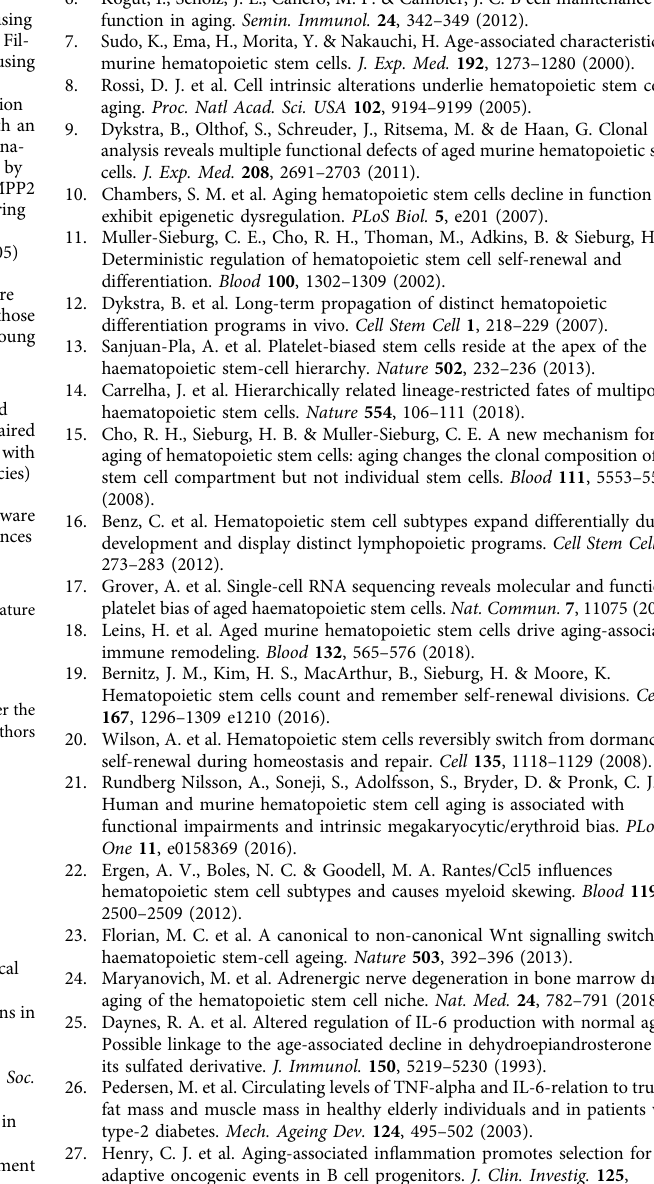
Fig. 5 TGF β R1 inhibition rebalances aged HSC lineage output. a GSEA analysis of MPP2-speci fi c genes in LSK cells from vehicle (VEH) and SB-treated old mice. Normalised enrichment score (NES) and P value are shown ( P < 0.001). b GSEA analysis of MPP4-speci fi c genes in LSK cells isolated from vehicle (VEH) and SB-treated old mice. Normalised enrichment score (NES) and P value are shown ( P < 0.001). c tSNE plot of vehicle and SB-treated single LSK cell transcriptomes. d GSEA analysis of MPP4-speci fi c genes in computationally de fi ned MPP4 cells isolated from vehicle and SB-treated old mice. The normalised enrichment score (NES) and P value are shown ( P = 0.014). e Fraction of LSK cultures from vehicle and SB-treated old mice (10 cells plated/ culture) positive for B-lymphocytes after 3 weeks of culture. N = 192 cultures/condition, two independent experiments. *** P < 0.001 (two-sided χ 2